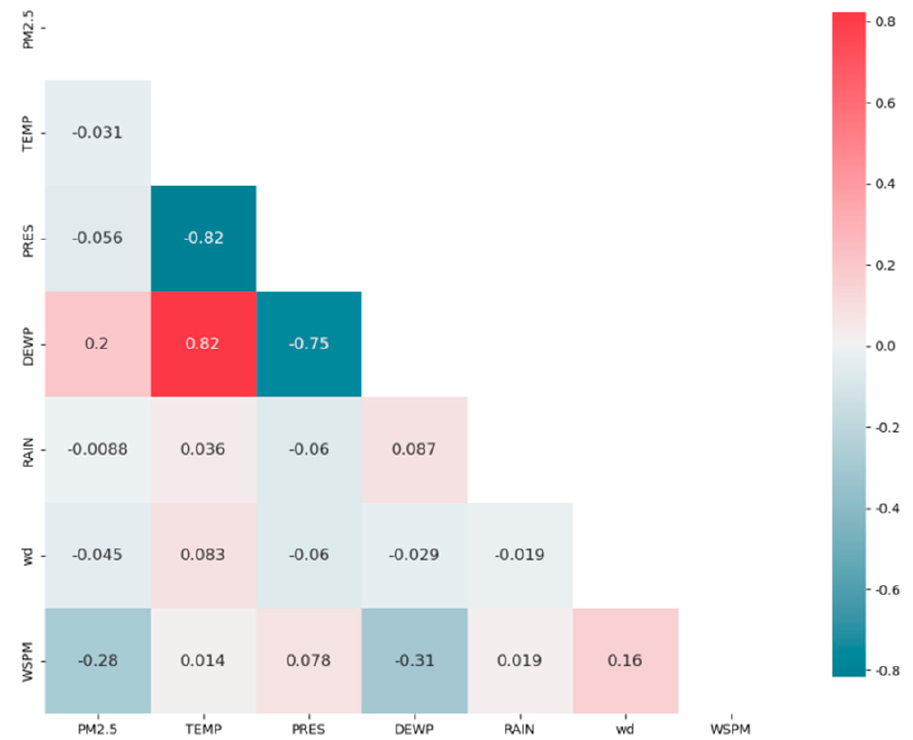
Figure 5. Heat map of correlation between PM 2.5 concentration and climatic variables.